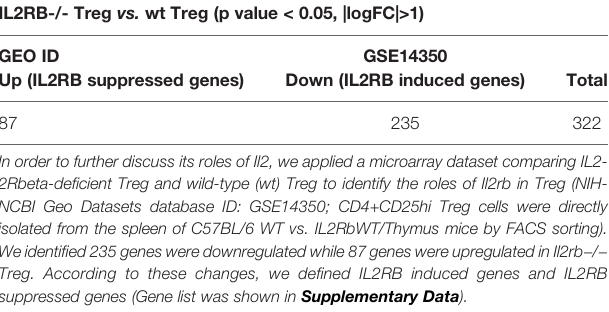
TABLE 8A | Our data and many other studies identi fi ed the function of interleukin-2 (IL2) in facilitating development and maintaining hemostasis of Treg.